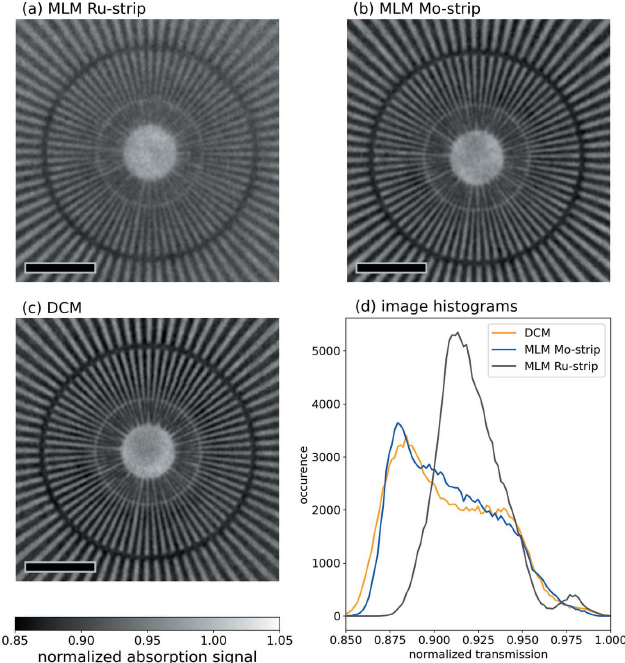
Figure 5 ( a )–( c ) Normalized (dark image and flat-field corrected) projections of the Siemens star in absorption contrast mode. The scale bar corresponds to 3 m m. The dark ring corresponds to 200 nm feature sizes, the light ring to 100 nm feature sizes and the smallest features on the Siemens star are 50 nm. ( d ) Histogram of the above images. The width of the main peak is equal for the Si-111 DCM and Mo/B 4 C MLM stripe and much narrower for the blurrier image acquired with the Ru/B 4 C MLM stripe.